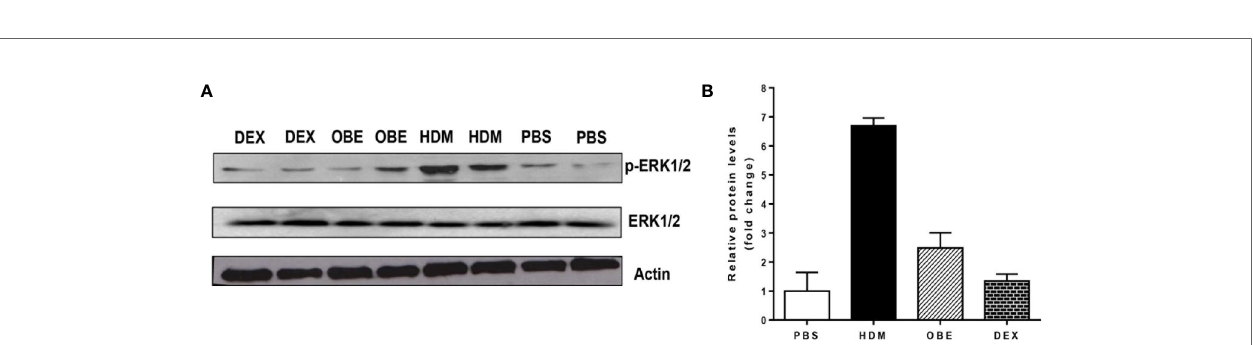
FIGURE 6 | (A) Western blot analysis of pERK1/2 and total ERK1/2 protein levels from lungs of PBS-challenged mice pretreated with vehicle (PBS), HDM- challenged mice pretreated with vehicle (HDM), HDM-challenged mice pretreated with OBE (60 mg/kg; i.p.) (OBE) and HDM-challenged mice pretreated with dexamethasone (DEX). The blots are of two pooled lung sample (n = 3, for each). (B) Graph b shows relative densitometric quanti fi cation levels of pERK1/2 (relative to total ERK1/2, both normalized to b -actin).